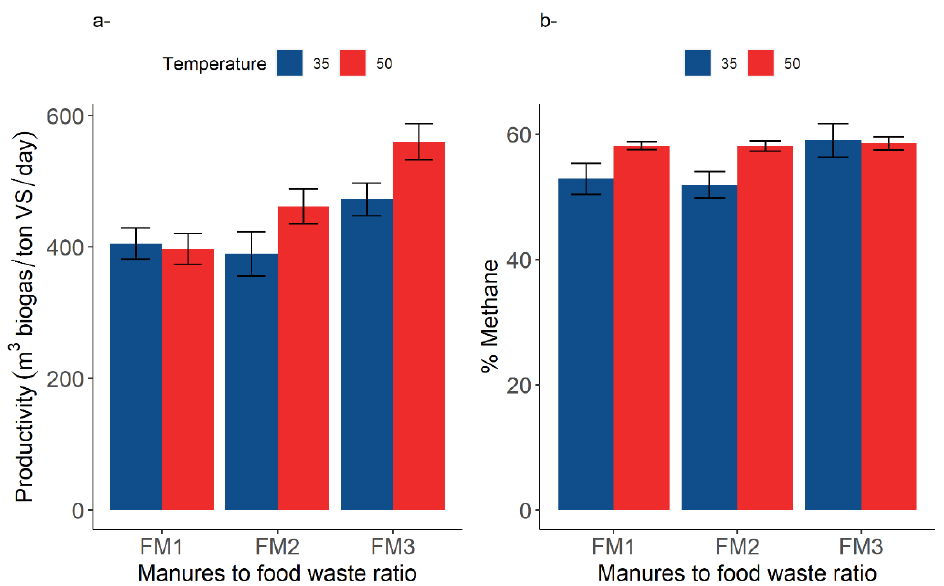
Figure 4. ( a ) Average biogas productivity (m 3 biogas/ton VS/day) during the last five weeks of the experiment, corresponding to the steady state. ( b ) Average methane content in the biogas during the steady state.